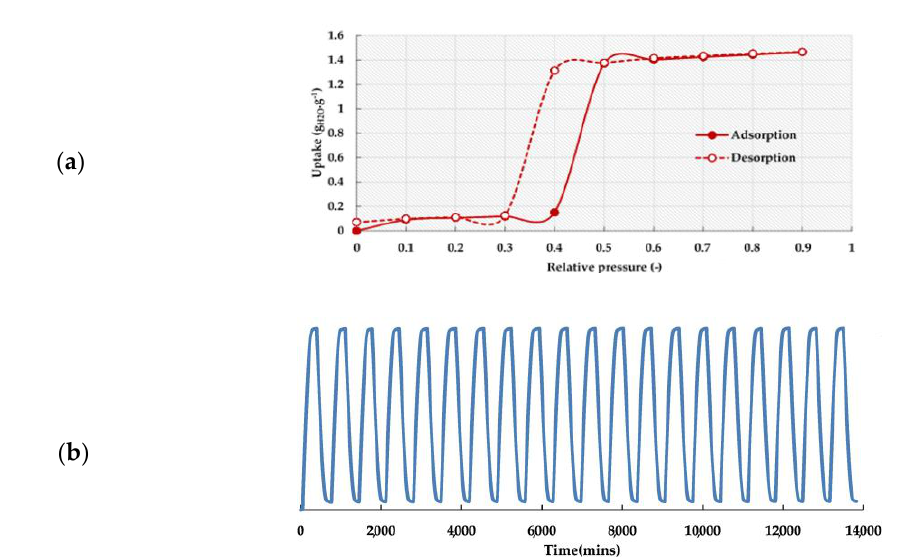
Figure 7. ( a ) Water adsorption isotherms of MIL-101 at 298 K and ( b ) Adsorption/desorption performance of MIL-101(Cr) at 298 K. Reproduced with permission from [69]. Elsevier, 2017.